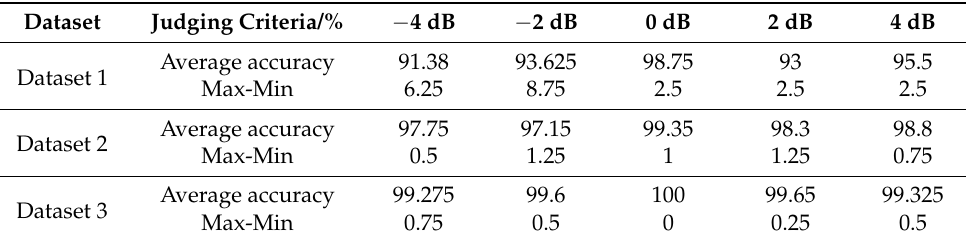
Table 3. Comparison of the performance comparison of different